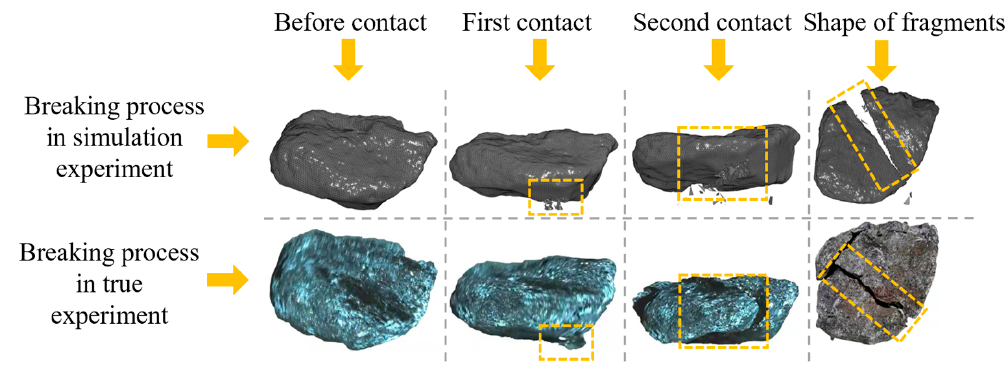
Figure 4. True and numerical simulation of coal fragmentation process.